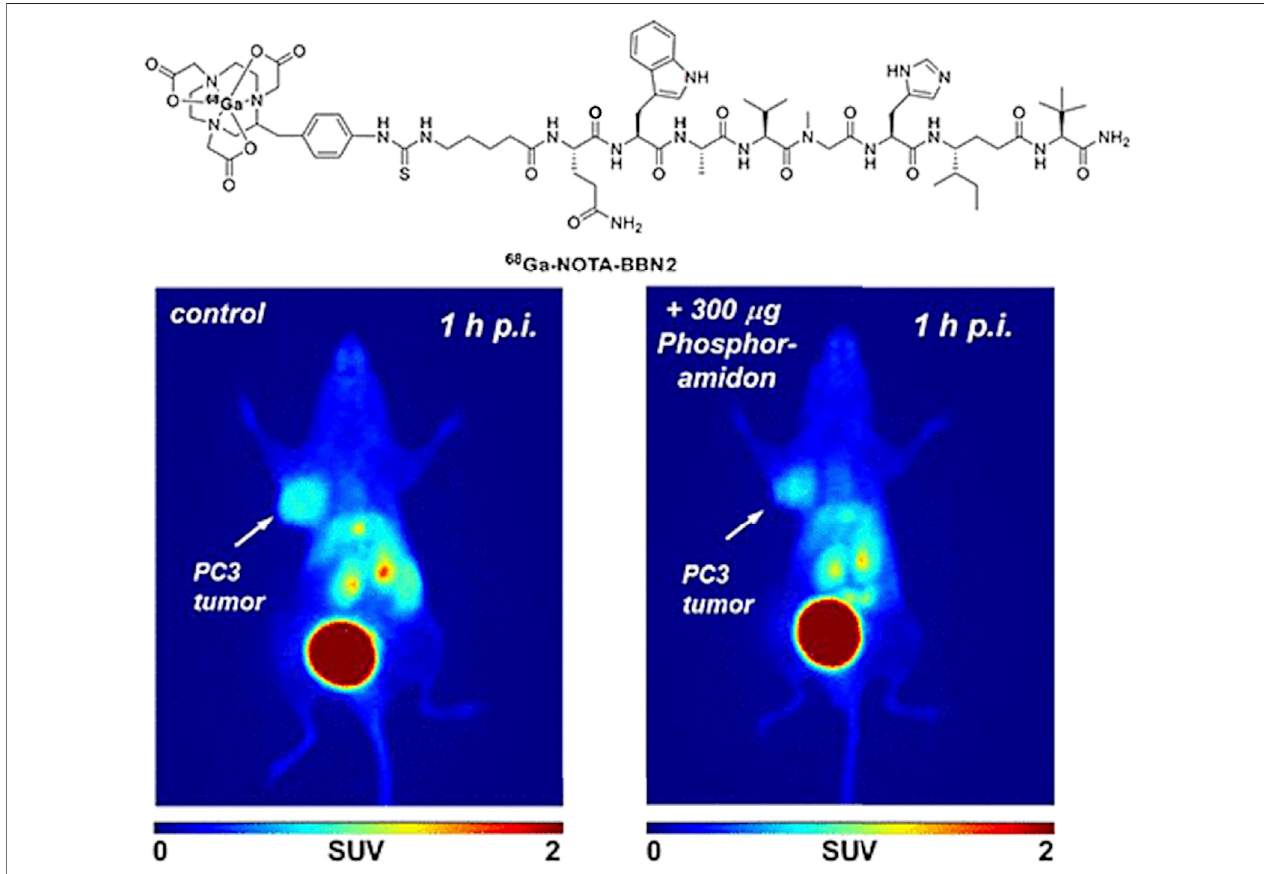
FIGURE6| PETimagesobtainedusing[ 68 Ga]-NOTA-BBN2 inPC3 (left)orLNCaP (right)tumor-bearingmicexenograftsadditionallytotheconsiderable uptake in the gallbladder and the bladder. Reproduced from reference (Richter et al., 2016).